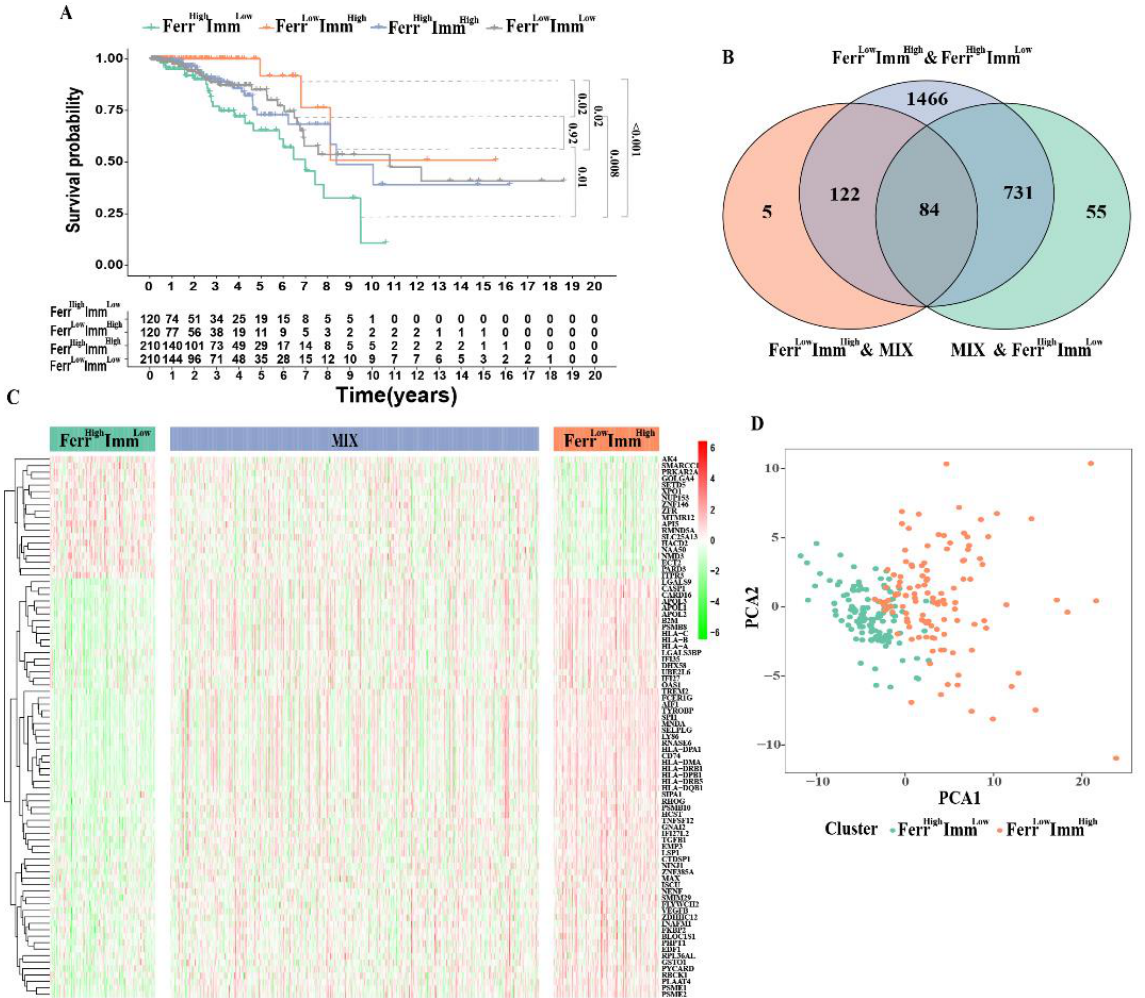
Figure 2. Ferroptosis and immune − related subtypes identification: ( A ) Kaplan – Meier survival curves for overall survival stratified according to the combined FerrS − ImmS signature. ( B ) The Venn diagram shows the number of DEGs among the three subtypes. ( C ) Heatmap of DEGs to visualize the expression levels among Ferr High Imm Low (120), Ferr Low Imm High (120) and MIX (420). ( D ) PCA based on the expression profile of DEGs according to Ferr High Imm Low and Ferr Low Imm High group.